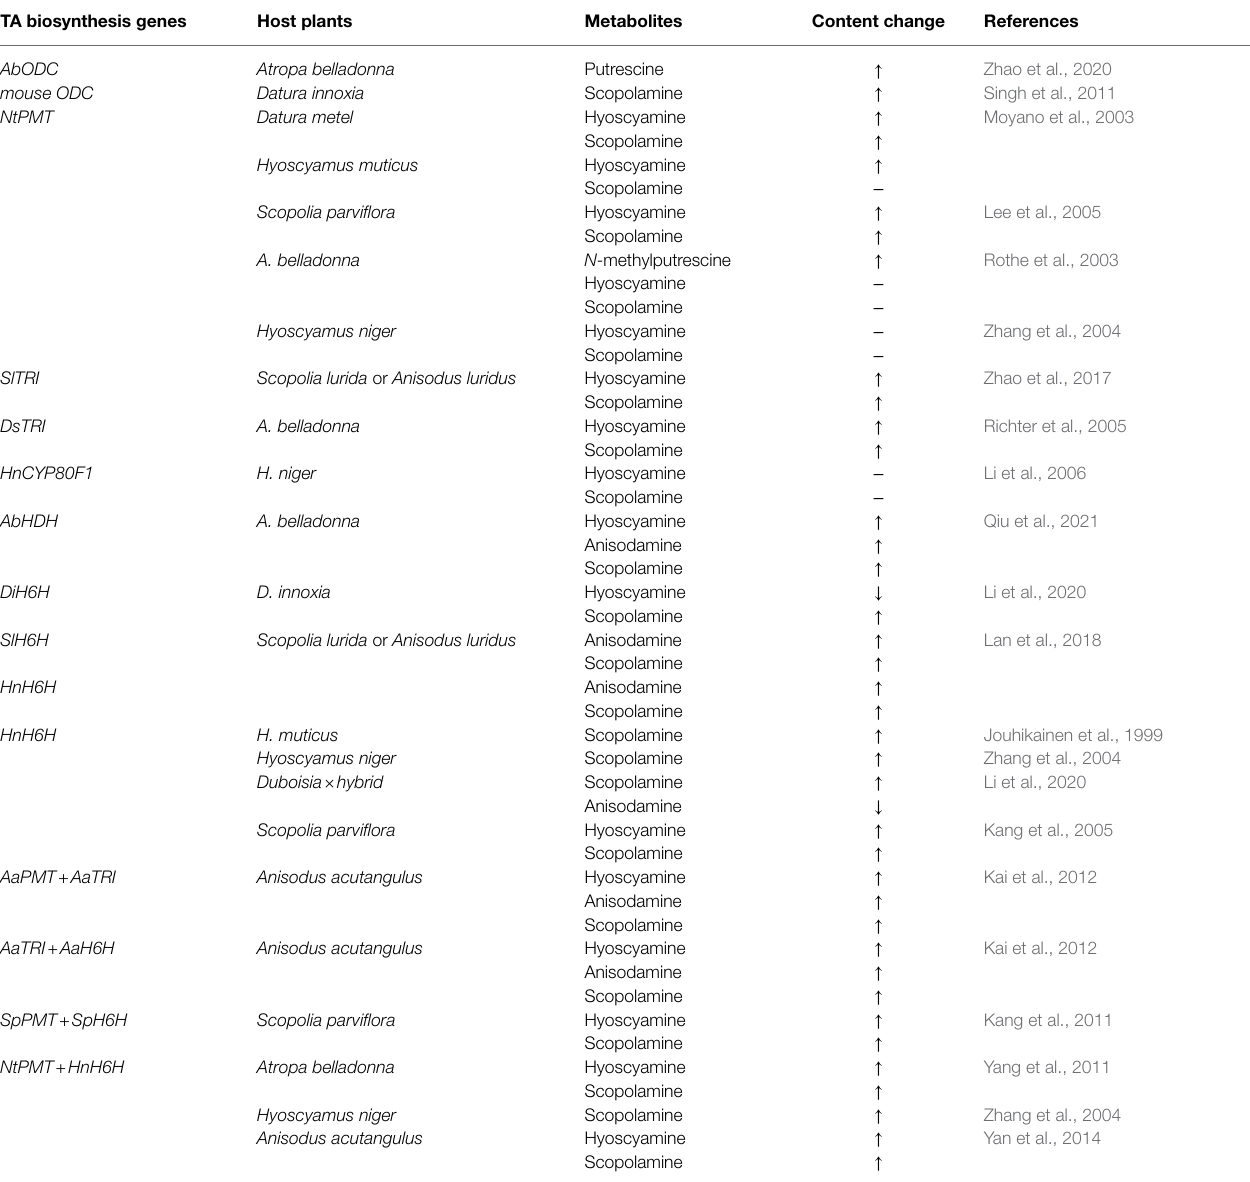
TABLE 1 | Engineering medicinal tropane alkaloid production in plant hairy root cultures through gene overexpression. TA biosynthesis